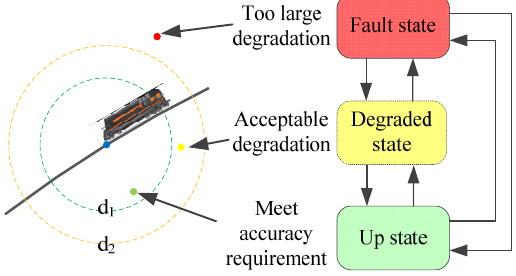
Figure 6. State of train